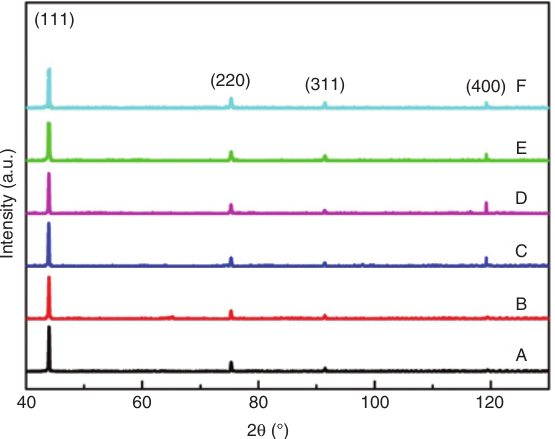
Figure 5: X-ray diffraction patterns of diamond film samples obtained at various gas flow rates (sccm). (A) O Ar-15; (C) O -1, Ar-14; (D) O 2